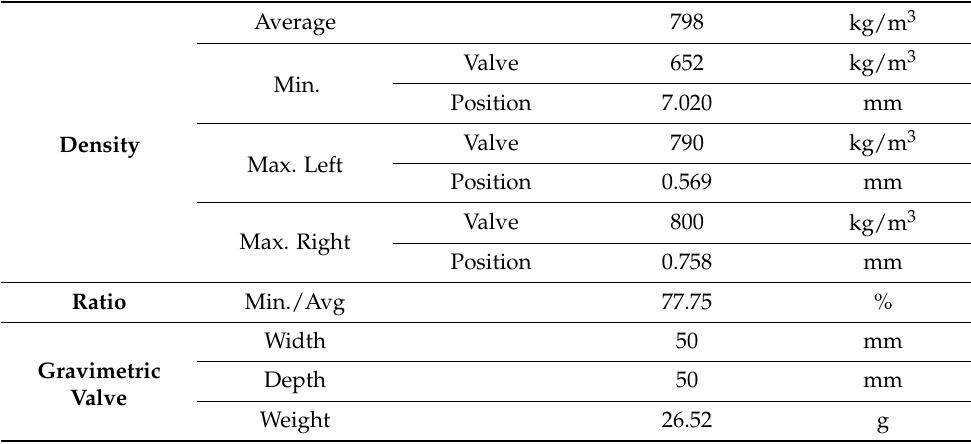
Table 15. Experimental data of 3rdsample.